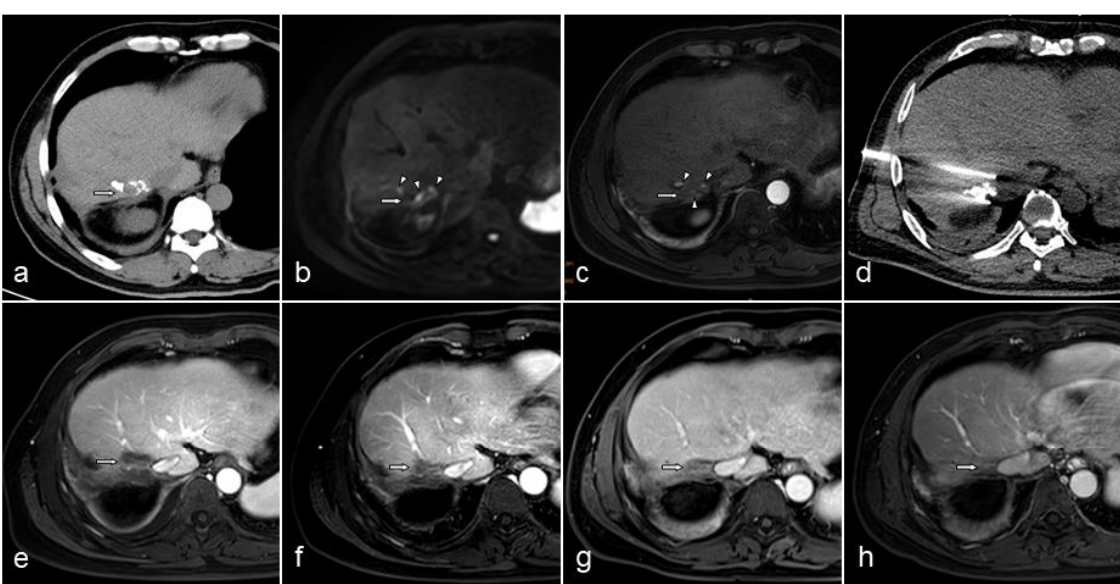
Figure 1. A 55-year-old male patient with hepatocellular carcinoma showing vessel patency after irreversible electroporation (IRE). Eight years ago, the chronic hepatitis B-infected liver mass was detected, surgically resected, and pathologically diagnosed to be hepatocellular carcinoma. Radiof- requency ablation and transarterial chemoembolization (TACE) was performed 4 years and 1 month ago, respectively, for tumor recurrence. IRE was then performed as the lesion was found active. ( a ) Computed tomography (CT) showed iodide deposition in the lesion 1 month after TACE. ( b ) Diffu- sion-weighted imaging showed a high signal in the lesion after TACE (arrow). ( c ) Contrast-en- hanced T1-weighted image (T1WI) showed partial enhancement in the arterial phase (arrowhead). ( d ) CT image during the IRE procedure showed the probes in place and ablation zone. ( e – h ) Con- trast-enhanced T1WI image in the venous phase showed hepatic vein and postcava remained pa- tent, and the lesion gradually shrank to almost invisible at 1, 3, 6, and 12 months post procedure. Table 6. Postoperative results.